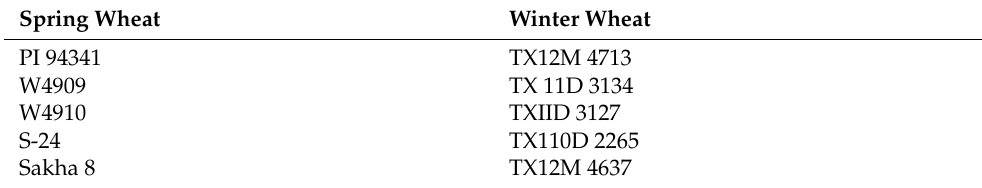
Table 3. Spring and winter wheat genotypes were used in this